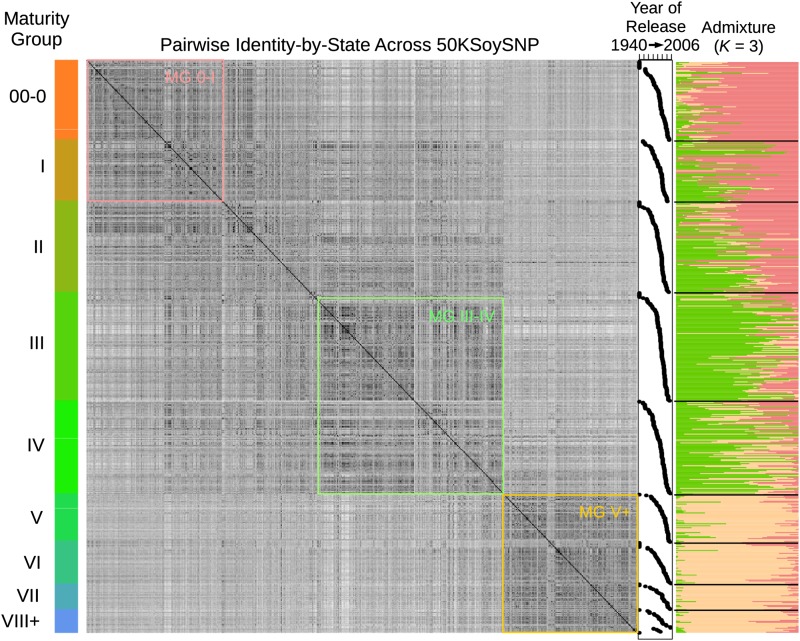
Population structure of modern public soybean varieties. Rows in the symmetrical IBS matrix are sorted by maturity group (right panel) and then by date-of-release as indicated in adjacent xy plots. Population assignments and admixture are shown in the far-right panel given a model of three populations (see Material and Methods). Colored boxes within the matrix indicate how the total set of accessions was divided into populations for further analysis. SNP, single nucleotide polymorphism.